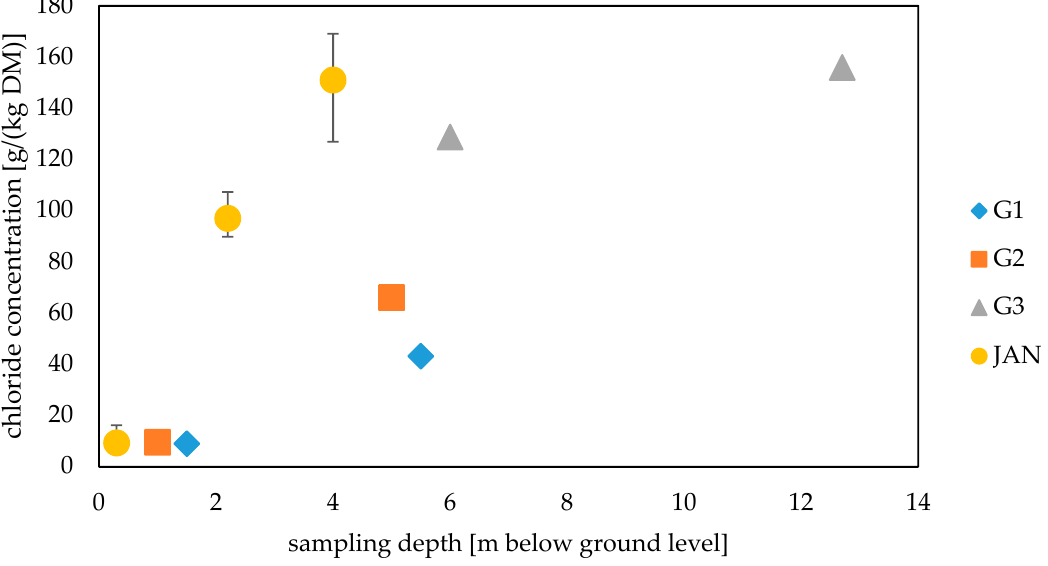
Figure 5. Concentration of chloride ions in solid waste samples collected at pond 8 (points G1–G3 were drilled as part of ongoing work; points JAN are the average results with minimum and maximum values obtained by the Janikosoda Production Plant in 1994–1996). Source: own study based on [11].